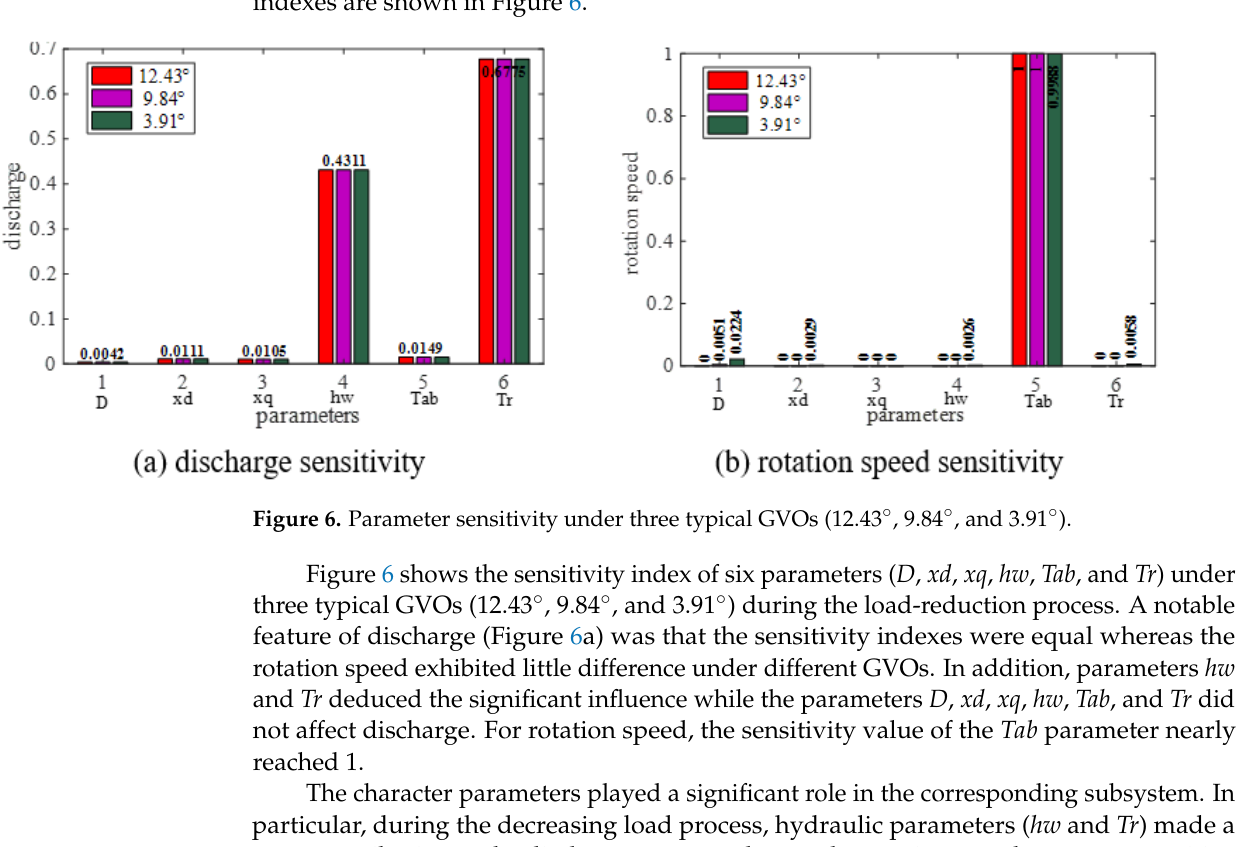
8 of 14 Figure 5. Responses of the HGS during load-reduction process. Table 2. HGS values under typical guide vane openings. Guide Vane Opening (GVO) Timing Point (s) Discharge (m 3 /s)